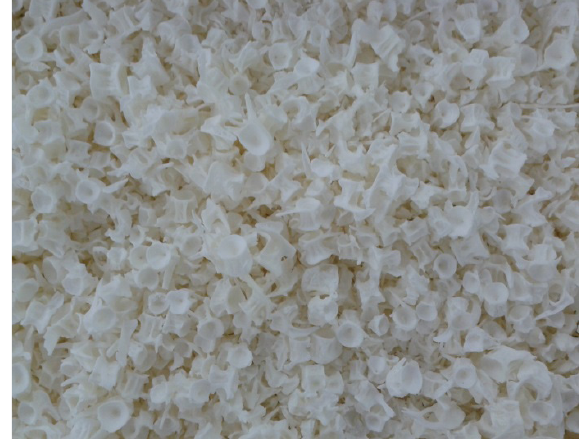
Figure 6: Final product BCP-calcium preparation from cod.